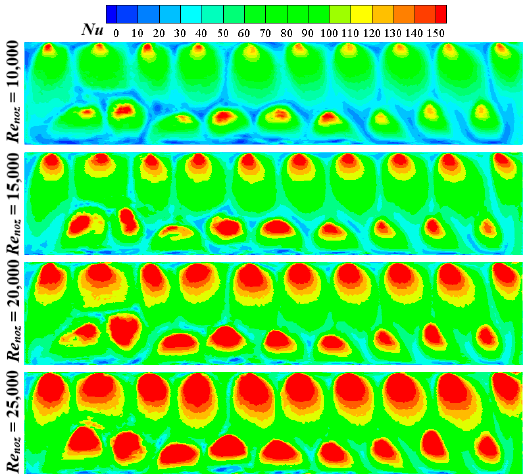
Figure 14. Local Nusselt number on the target surface of the compound cooling unit at different Re noz .